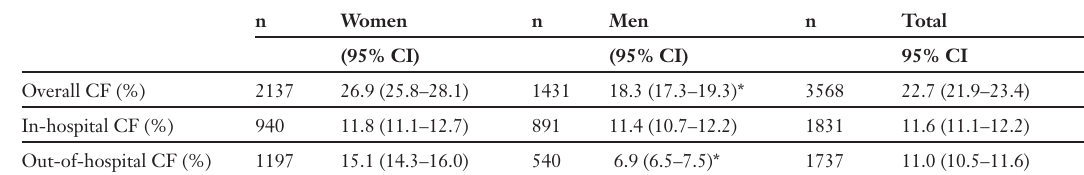
Overall case fatality (CF), in-hospital CF and out-of-hospital CF; women, men (Switzerland